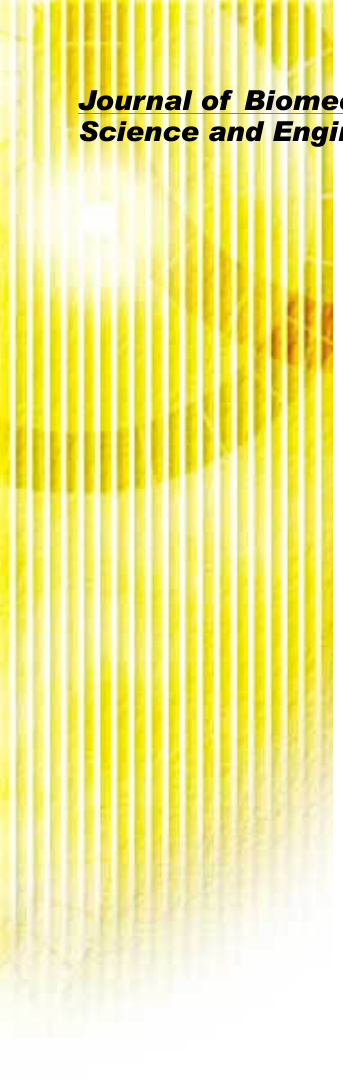
=50 dyne/cm 2 (5.0 Pa). th